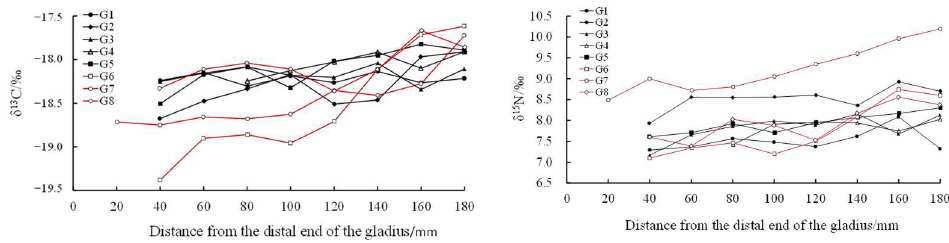
Figure 6. Relationship between δ 13 C‰, δ 15 N‰, and the growth of the proostracum of T. pacificus collected in the East China Sea. (Black line represents males, and red line represents females.)